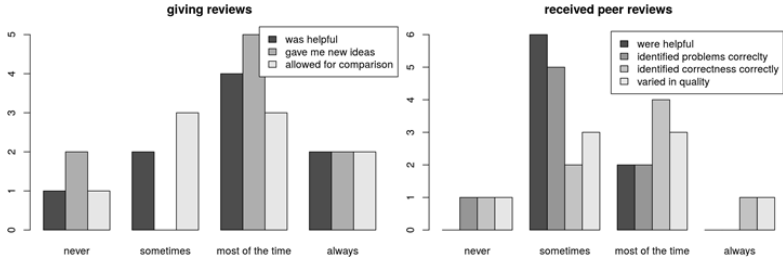
Fig. 4. Perceived properties of given and received peer